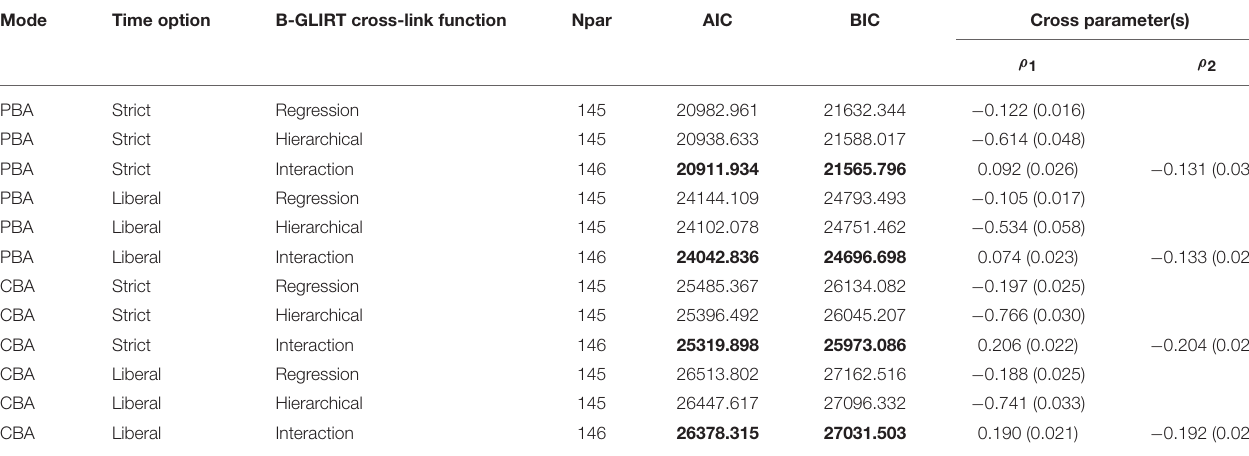
TABLE 1 | Information criteria for the model comparison (different parameterizations of the cross-relation). Mode